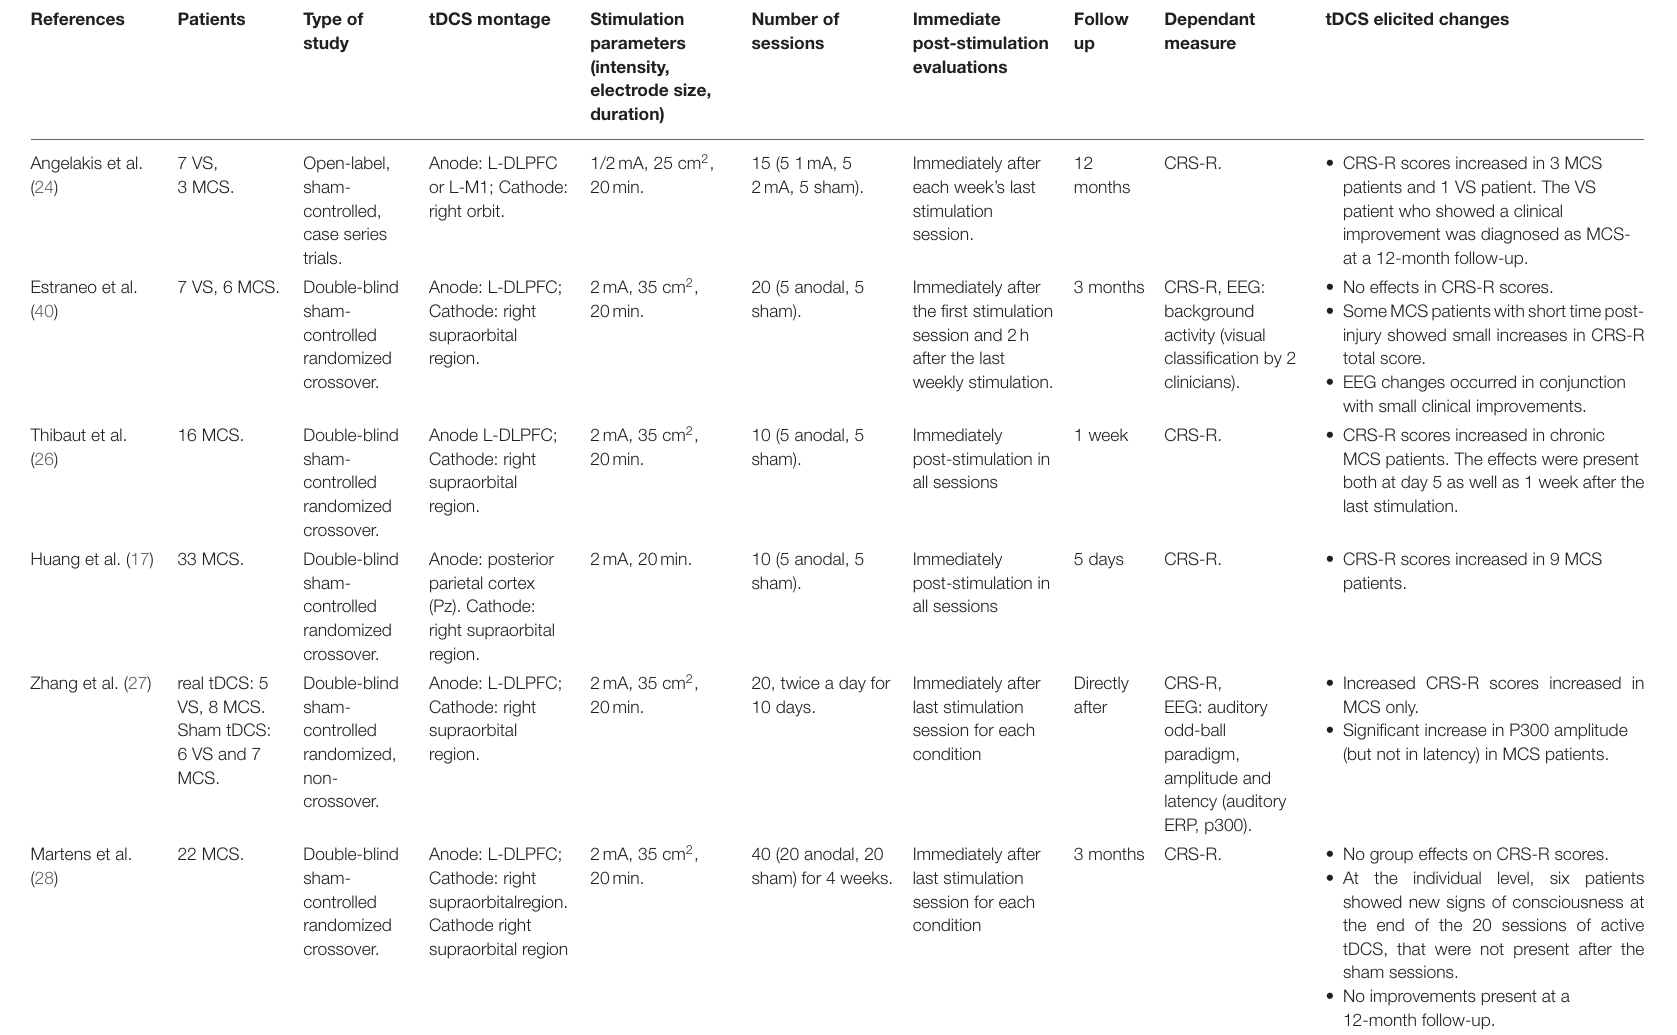
TABLE 2 | Overview of multiple session tDCS studies in